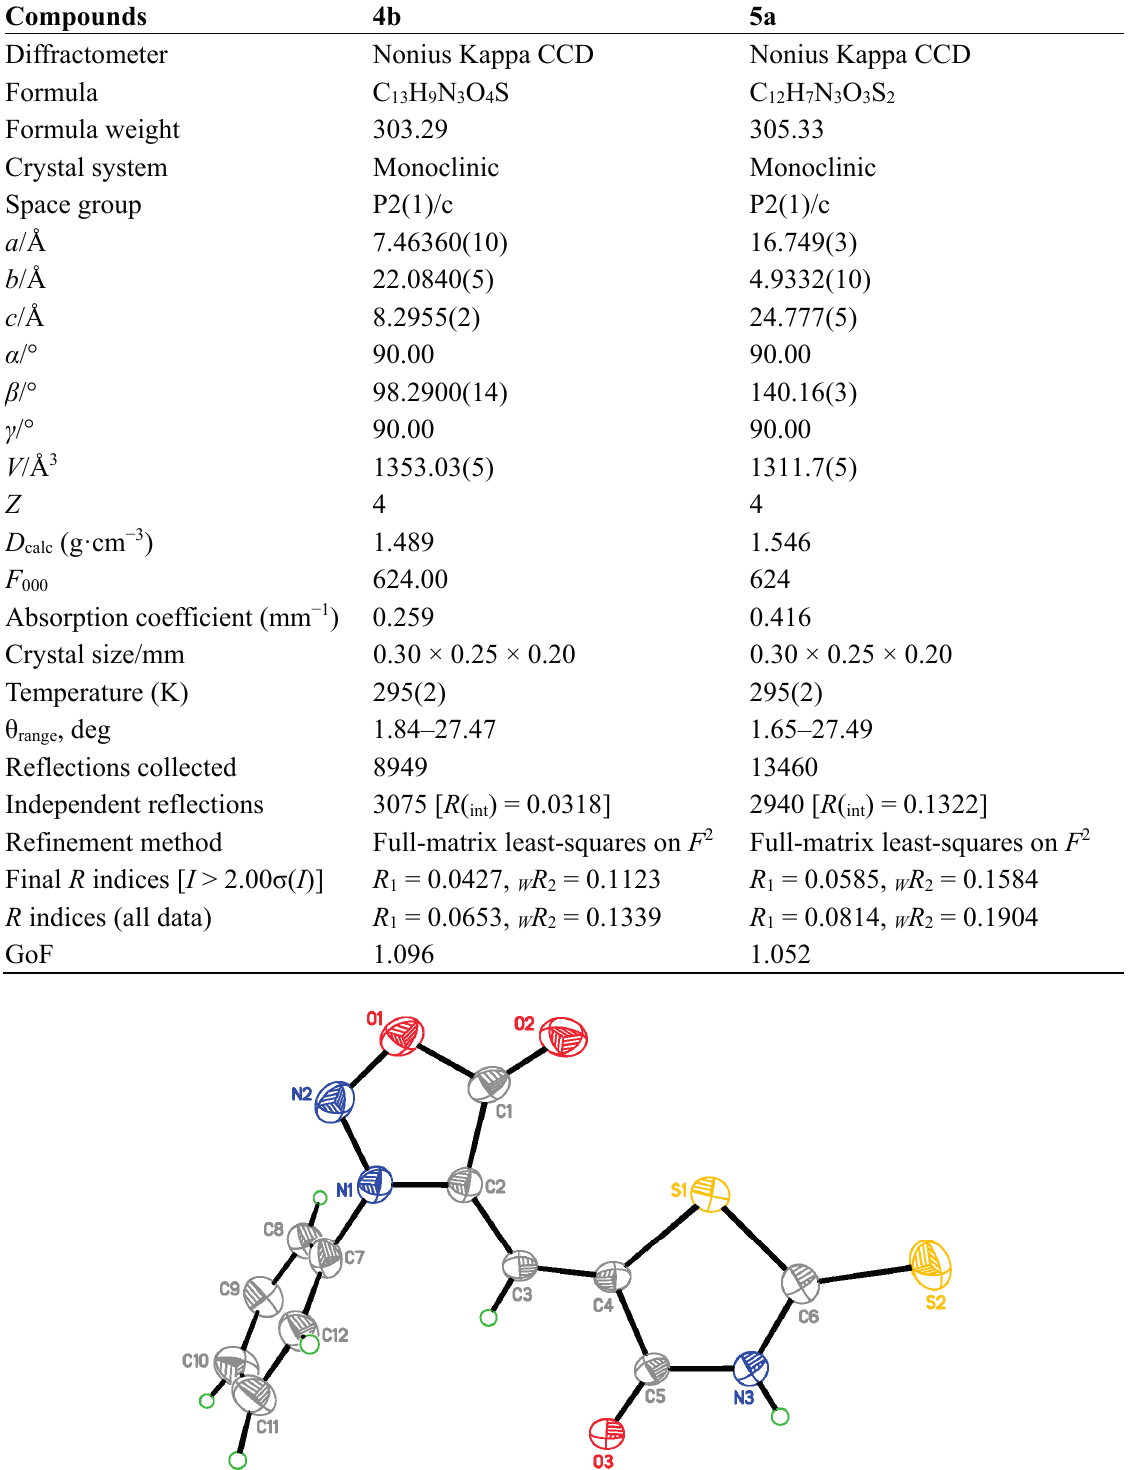
Table 1. Crystal Data of compounds 4a and 5b .